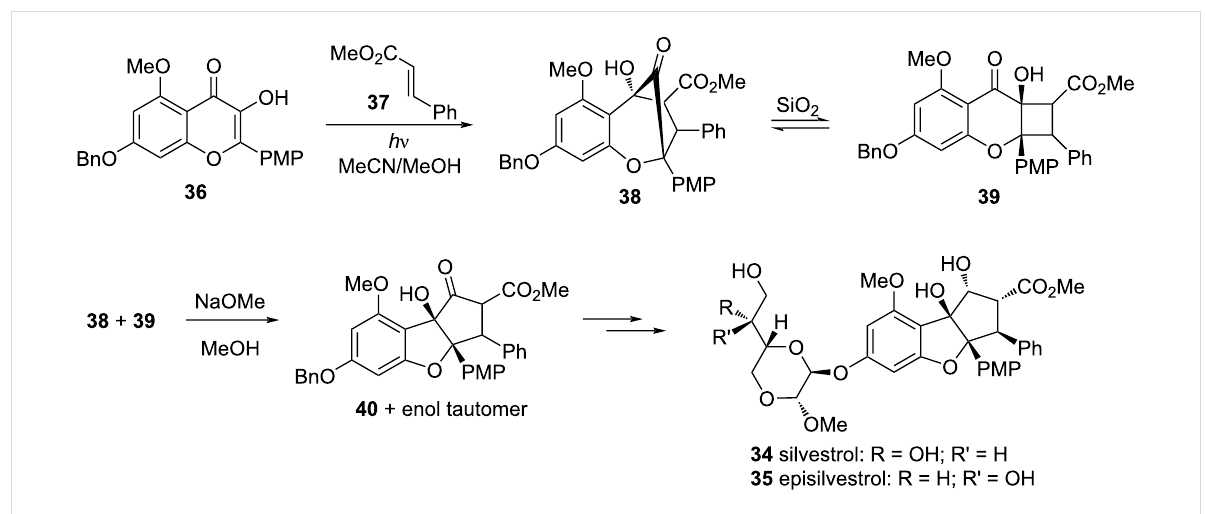
Figure 9: Two α -ketol rearrangements, one catalyzed by silica gel on 38 and the other by NaOMe on both 38 and 39 , part of the total synthesis of silvestrol ( 34 ) and episilvestrol ( 35 ). PMP = p -methoxyphenyl.